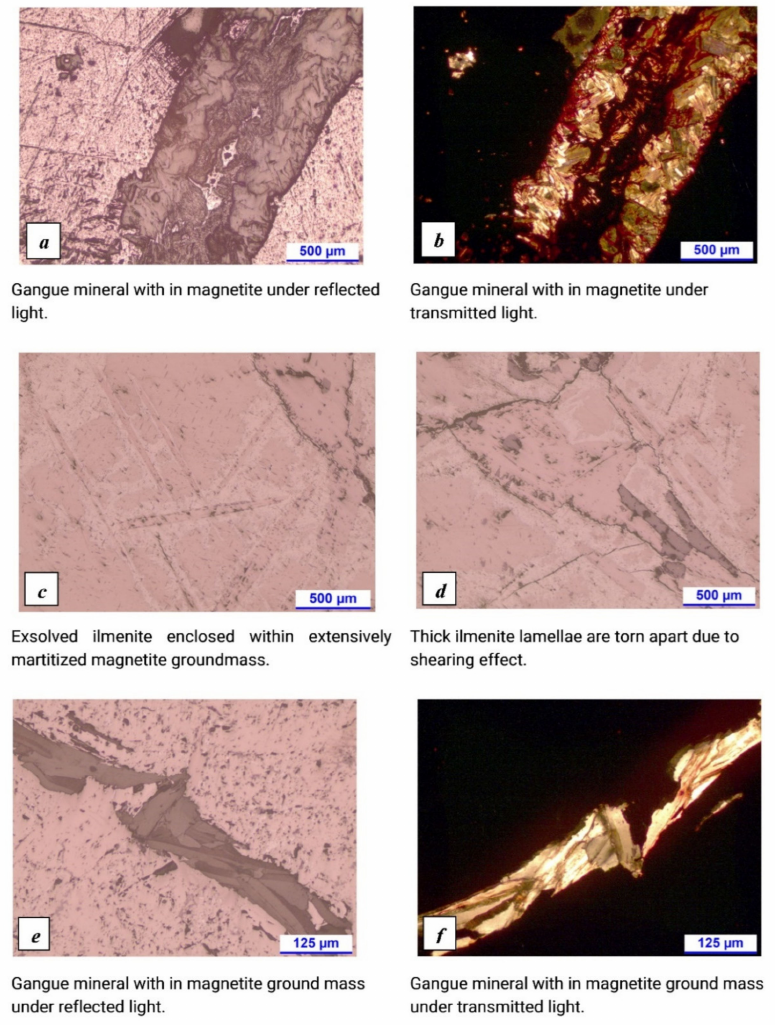
Figure 11. ( a – f ) Photomicrographs of thin cum polished section under the microscope showing different minerals and